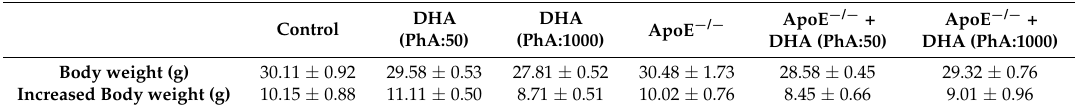
Table 2. Effects of DHA (PhA:50) and DHA (PhA:1000) on body weight and increase body weightin ApoE − / − and wild-type